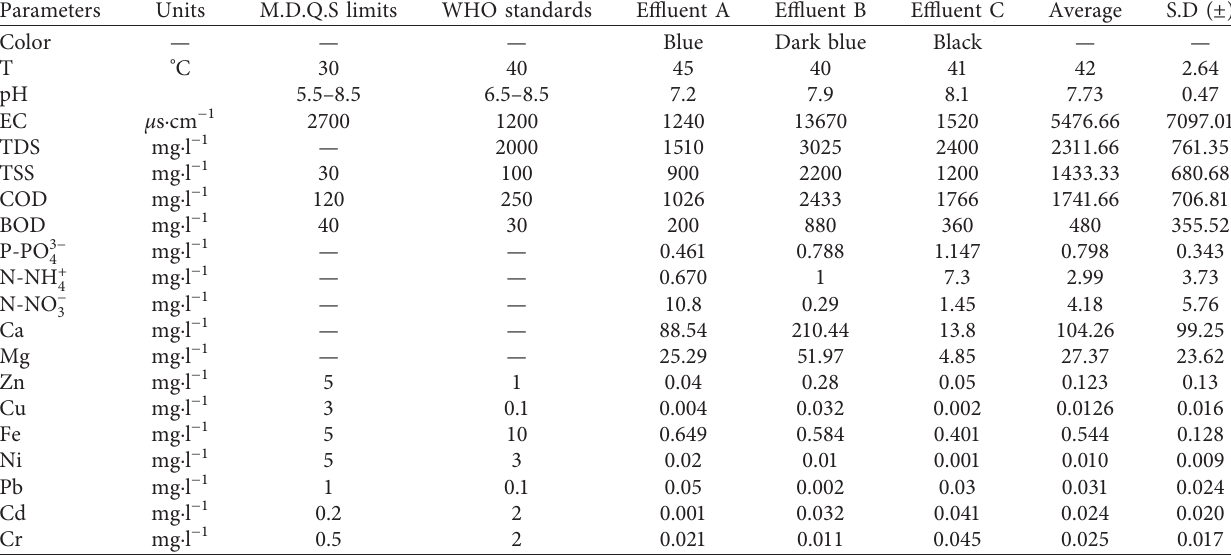
Table 1: Physicochemical characterization of textile effluents compared with M.D.Q.S and WHO standards.